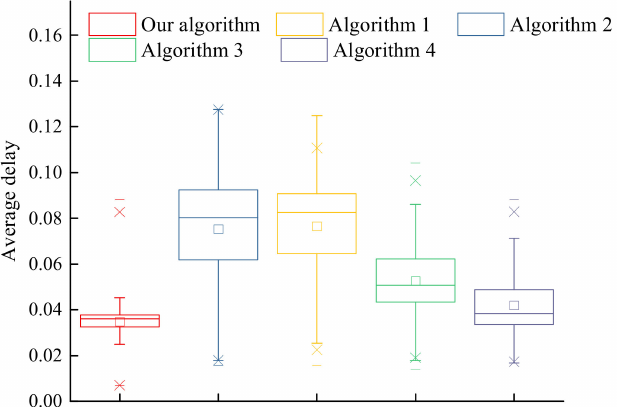
Figure 7. Box graph of end-to-end delay.